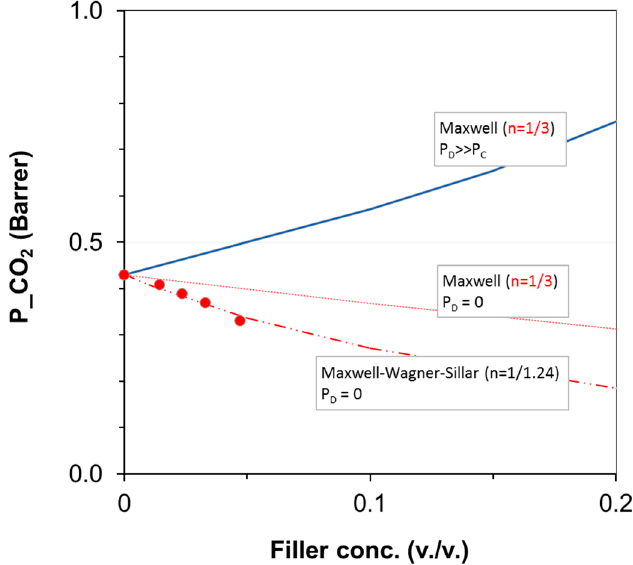
Figure 9. CO 2 permeability measured through films of PA11 loaded with Zeo-Sal as a function of the filler volume fraction. The continuous lines correspond to the upper limit ( P d >> P m) and lower limit ( P d = 0) of the Maxwell model. The dashed line corresponds to the fitting of the experimental points using the Maxwell-Wagner-Sillar model with P d = 0.